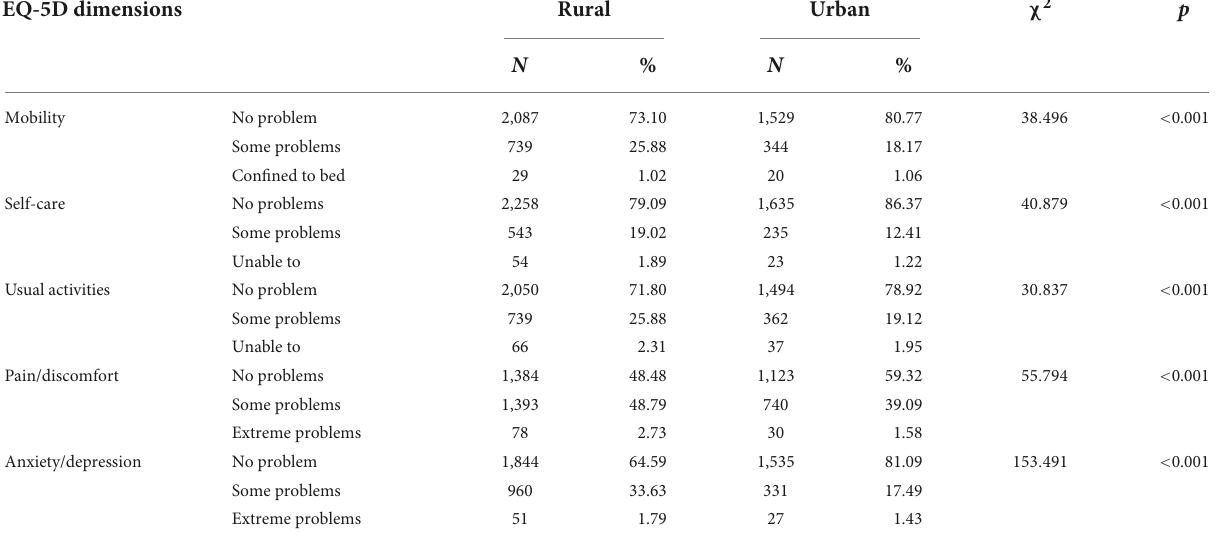
TABLE 3 Health status distribution on the five dimensions of European Five Dimensions Questionnaire (EQ-5D-3L). EQ-5D